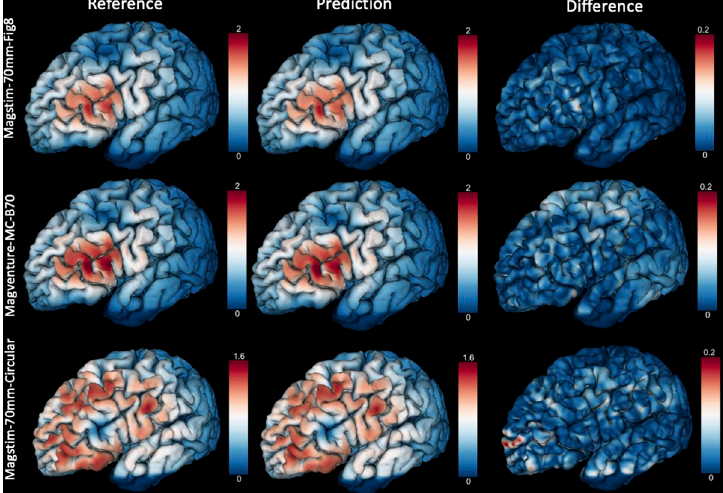
Fig 4. The magnitude [V/m] of E-field from VCM (the first column) and C-60 (the middle column), and the absolute difference between VCM and C-60 (the last column) for three types of TMS coils placed at the same position of a testing subject of the HCP dataset.